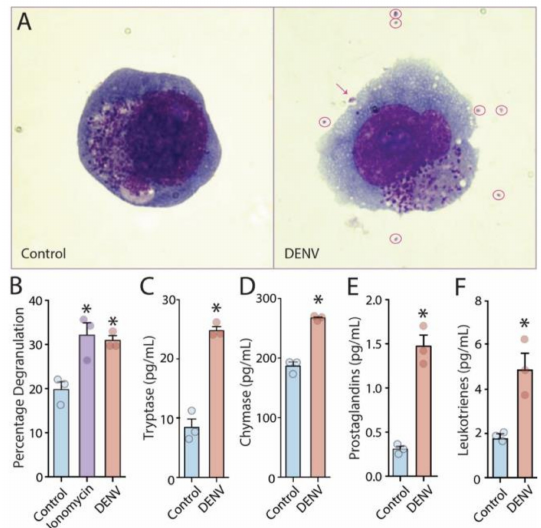
Figure 1. huMC activation by dengue virus (DENV) is characterized by degranulation and eiocosanoid production. ( A ) Images are representative of control-treated or DENV-activated huMCs. Control huMCs appear granulated and quiescent in comparison to DENV-activated huMCs, which degranulate. Extracellular granules are circled and an arrow points to a granule that is in the process of being released from the huMC surface. Images are representative of multiple cells observed from 3 independent experiments. ( B ) Percentage of degranulation was quantified by β -hexosaminidase assay; * indicates significant degranulation compared to control (spontaneous release) for both ionomycin and DENV stimulation ( p < 0.05). ( C , D ) ELISAs confirmed release of granule-associated proteases, ( C ) tryptase and ( D ) chymase. Eicosanoid mediators, ( E ) prostaglandins and ( F ) leukotrienes are induced by DENV treatment of huMCs at 1 h post-treatment with DENV. Dots represent technical replicates. * indicates p < 0.05 by 1-way ANOVA (panel B) or Student’s un-paired t -test (panels